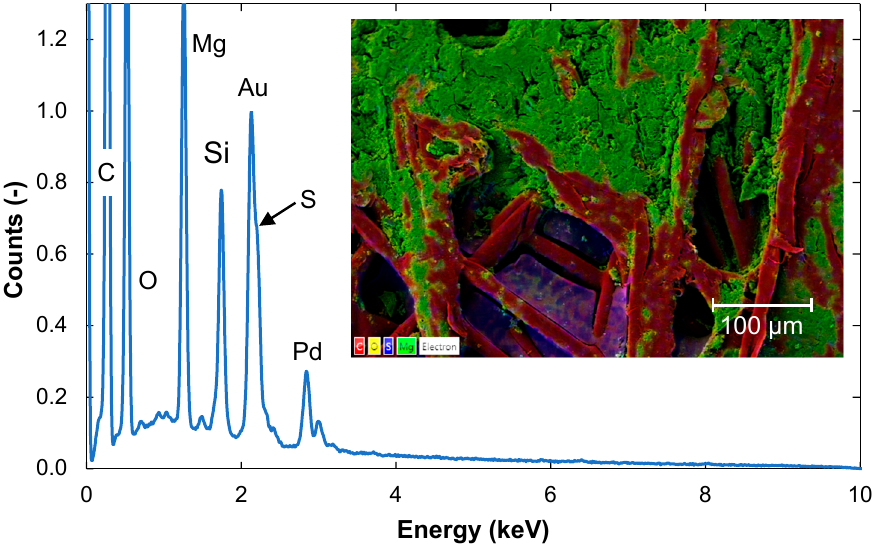
Figure 8. EDS spectrum of the backing of a membrane sample that had been cleaned for 20 h. A SEM image of the membrane surface is shown in the insert. The elements present and normalization are as described in Figure 2.